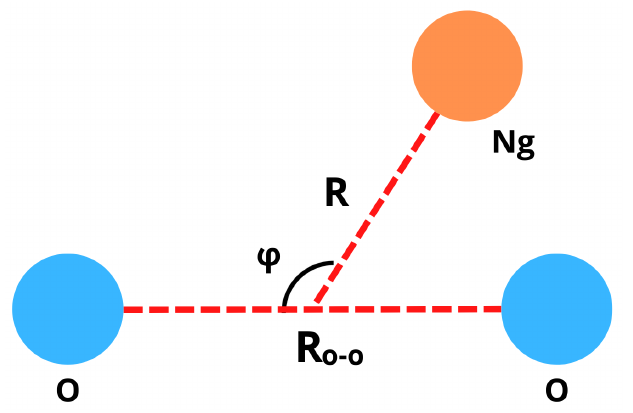
Figure 1. Geometric variables defining the structure of Ng–O 2